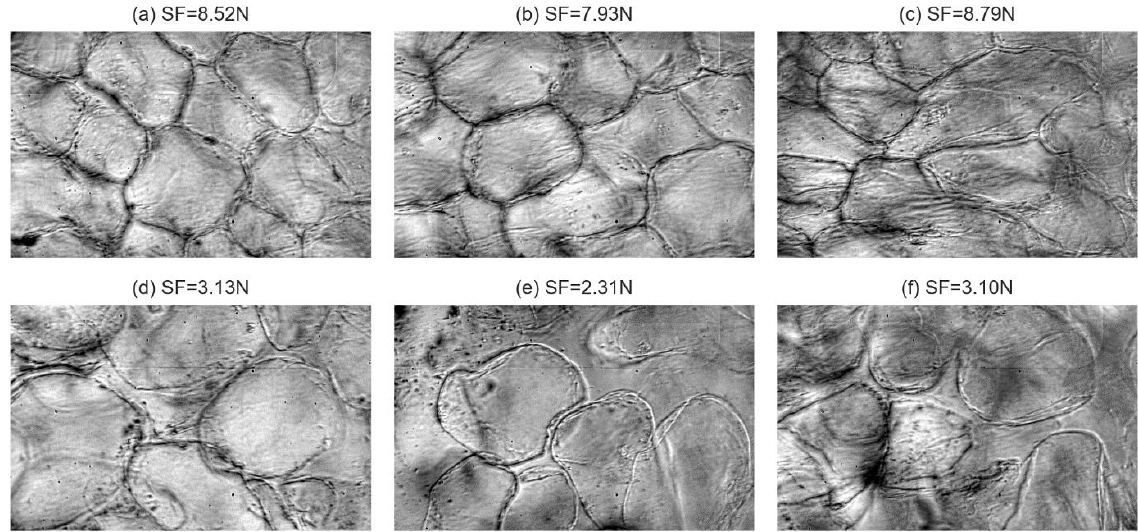
Figure 6. Parenchyma cells in blueberry fruit with different firmness; ( a – c ) SF 7.85-8.83 N with tight cell-to-cell adhesion (CCA), thick, dark, and stiff cell walls (CW), small intercellular spaces (IS); ( d – f ) SF 1.96–3.92 N with more CCA lost, thinner, light, loosened CWs, very large IS.